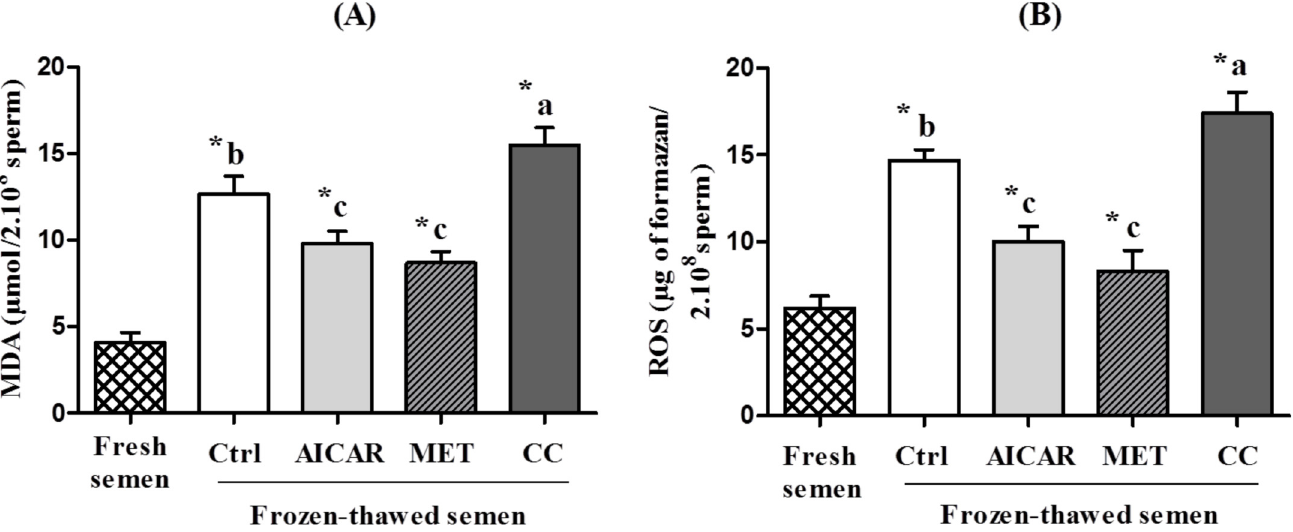
Fig 2. Effect of AMPK inhibitor CC and activators AICAR and MET on ROS and lipid peroxidation (MDA) in frozen-thawed chicken sperm. Sperm were treated in the presence of an AMPK activator (2mM AICAR (in light gray) or 1mM MET (in diagonals)) or an AMPK inhibitor (5 µ M CC (indark gray)) or Control (Ctrl, in white); Fresh semen (checkered pattern). (A) Lipid peroxidation (malondialdehyde), (B) Reactive oxygen species (ROS).Values represent means ± SEM from 6 different experiments (4 samples/experiment). Different superscripts indicate significant differences between Ctrl and treatments (AICAR, MET or CC) in frozen-thawed semen ( a,b,c , P < 0.01). Asterisks indicate statistically significant differences between fresh and frozen-thawed semen ( * , P < 0.001).